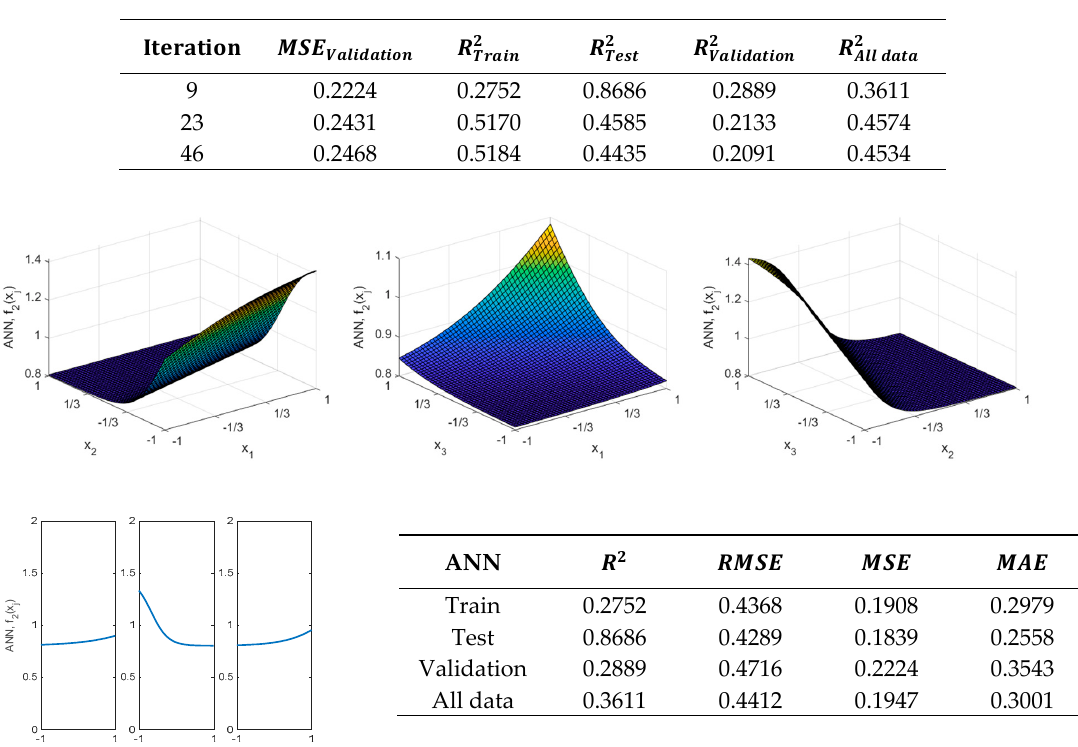
Figure 12. Response surfaces obtained, main effects plot and results of the validation metrics obtained with the ANN model for the case of type 2 function ( f 2 ) ( n = 1 neurons )